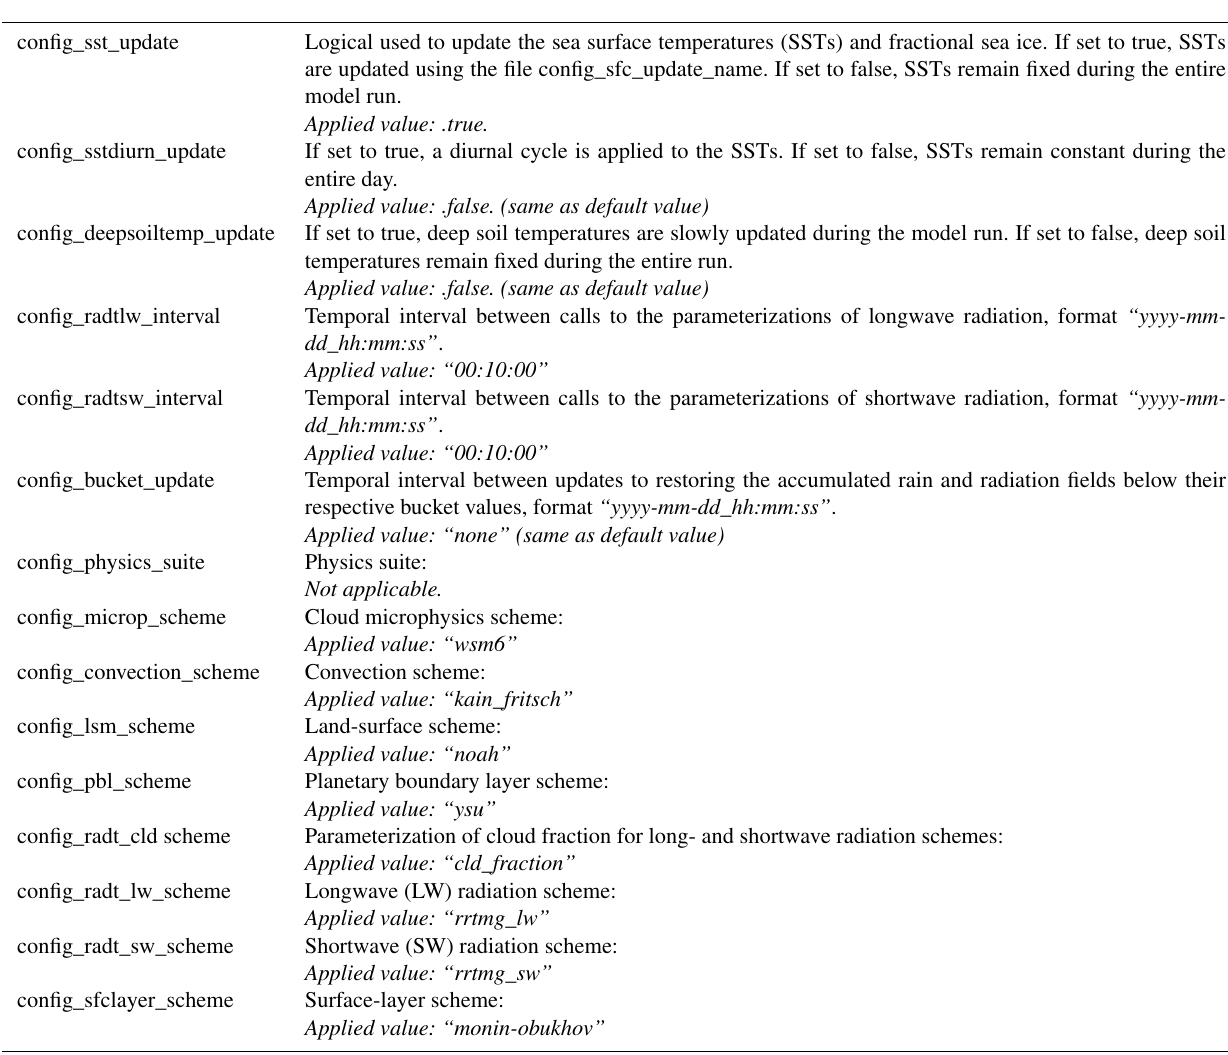
Table 2. Standard MPAS-A physics namelist variables used for